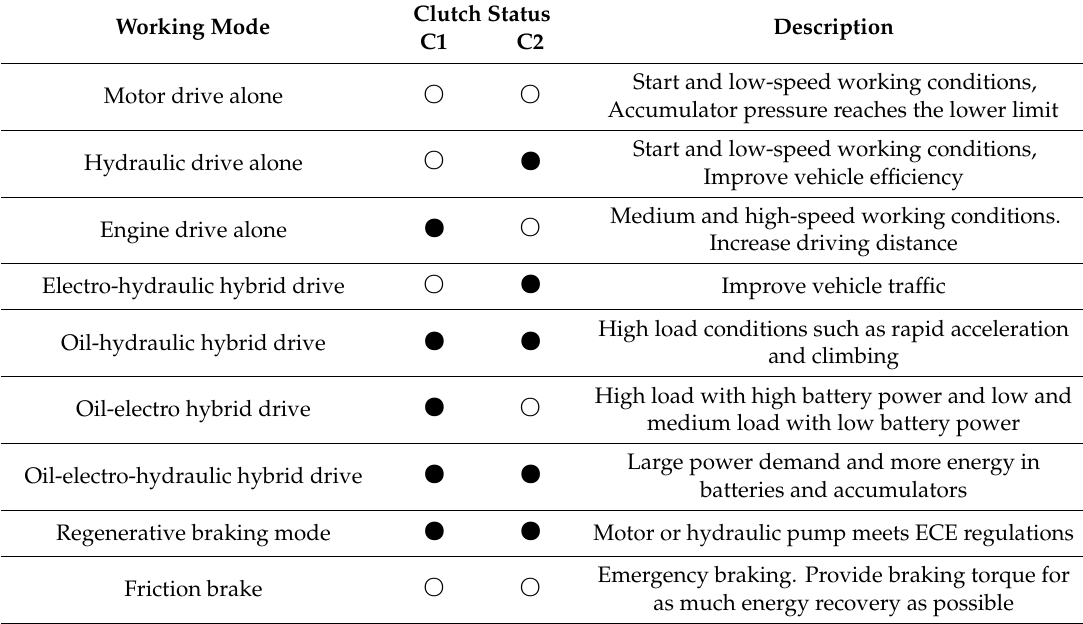
Table 2. Basic parameters of each key